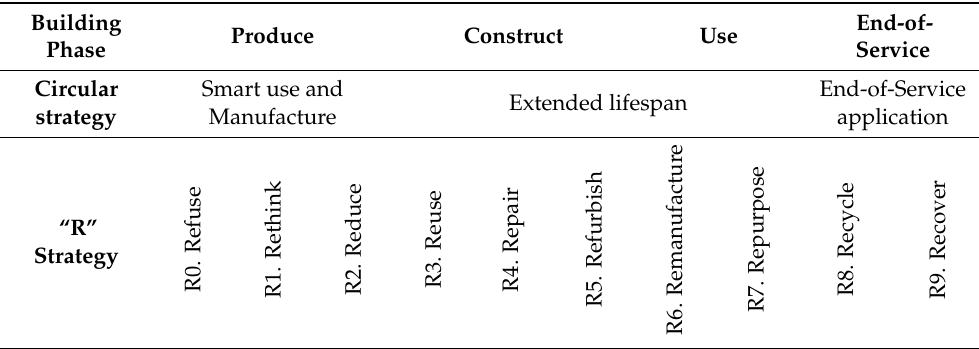
Table 1. Circular strategies within the production chain, in order of priority. Adapted and summarised from Potting et al. [24]. End-of- Produce Construct Use Service Smart use and Extended lifespan